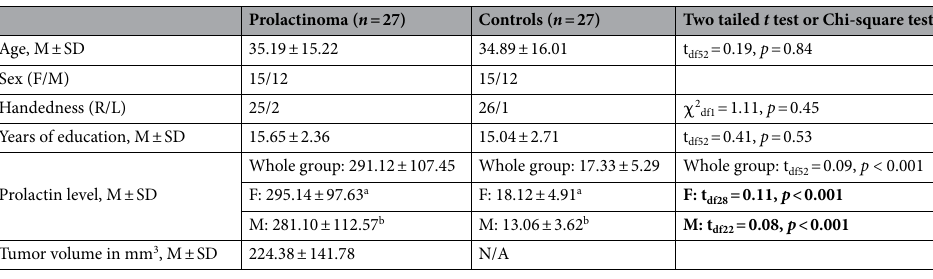
Table 1. Sociodemographic and clinical characteristics of patients with prolactinoma and healthy controls. Significant scores are shown in bold. M mean, SD standard deviation, F female, M male, R right, L left, N/A not applicable, ng/mL nanogram/milliliter. Normative values for prolactin— a F: 4.79–23.3 ng/mL; b M: 4.04– 15.2 ng/mL.